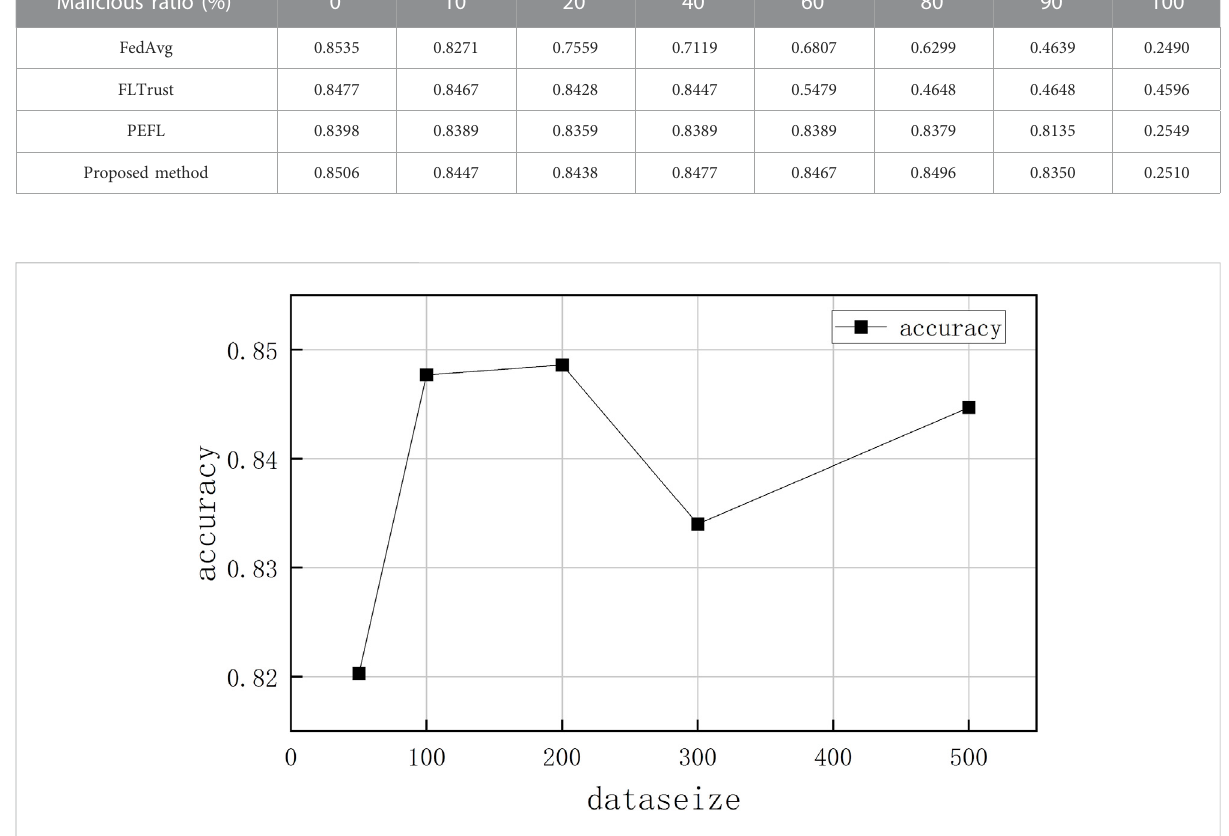
FIGURE 4 The impact of data center sample size on